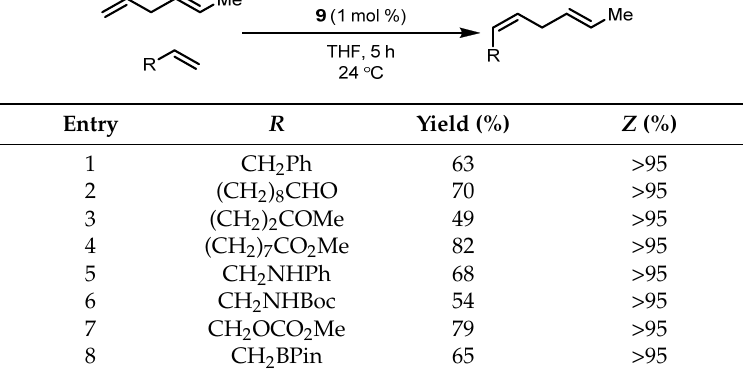
Table 8. Z -Selective CM of 3 E -1,3-dienes with terminal